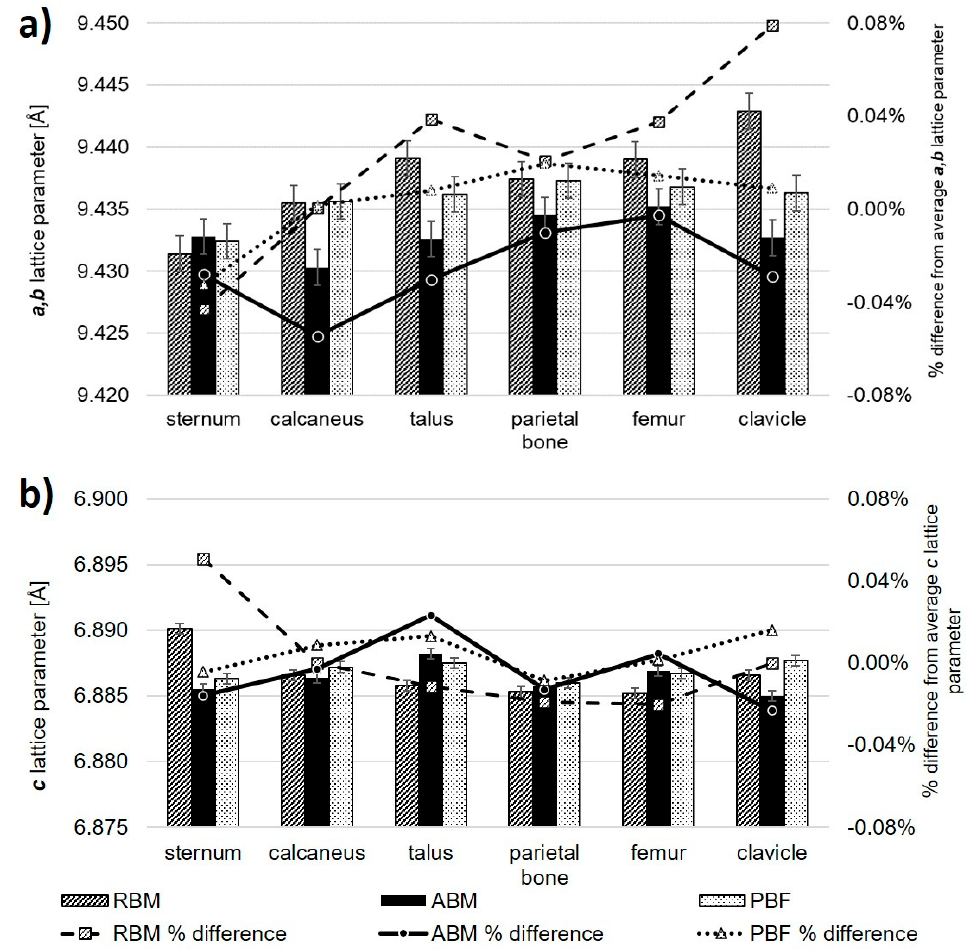
Figure 3. Absolute value of the lattice parameters as determined from Rietveld refinement of XRPD data (bars) and percentage di ff erence of lattice parameters with respect to average value for lattice parameter across all samples (points) are plotted in ( a ) for the a ( = b) lattice parameter and in ( b ) for the c lattice parameter,